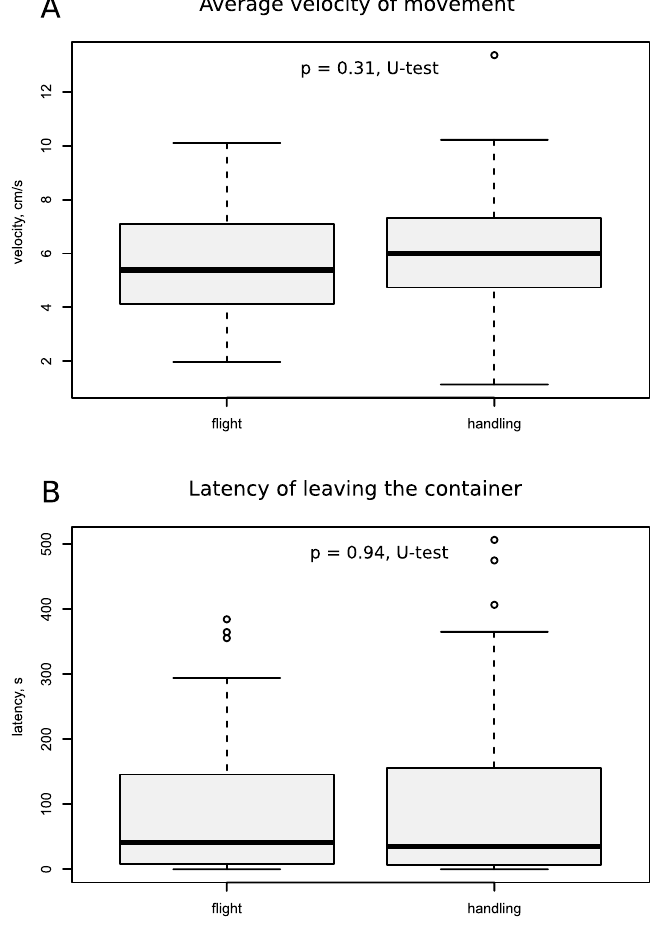
Figure 4. Quantitative parameters of motor behavior in the ’flight’ and ’handled’ groups of female crickets. The average velocity of locomotion in the arena (A) and the time they spent in the home container before leaving